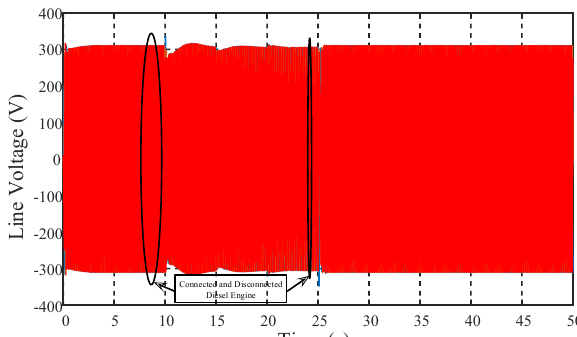
Figure 23. AC output voltage profile.